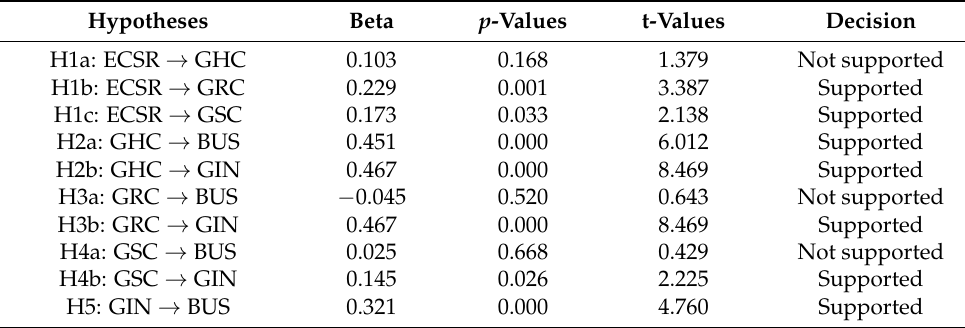
Table 9. Hypotheses Assessment